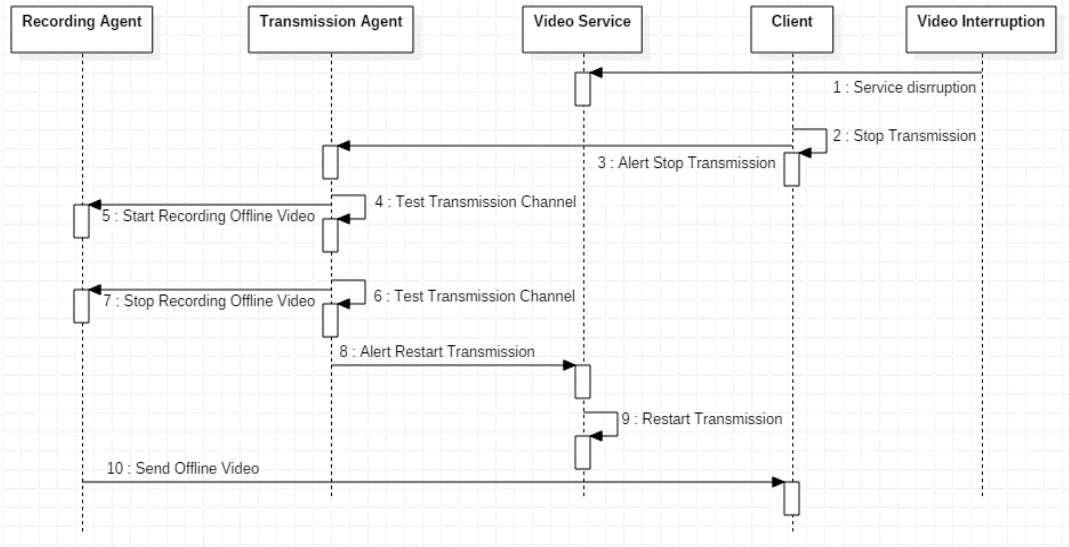
Figure 5. Sequence diagram for the treatment of a real time video streaming service disruption.